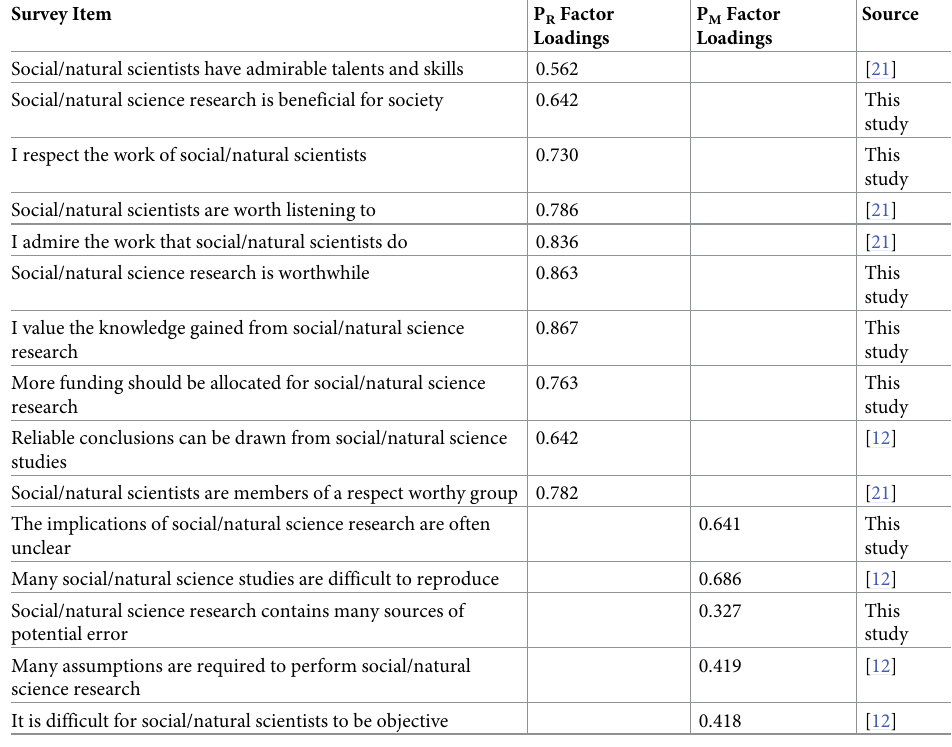
Table 3. Factor loadings and sources for survey items. Exploratory factor analysis with varimax rotation resulted in a Perceived Respect scale, P R , and a Perceived Methodological Rigor scale, P M . Factor loadings < 0.32 are suppressed [54]. Survey Item P R Factor